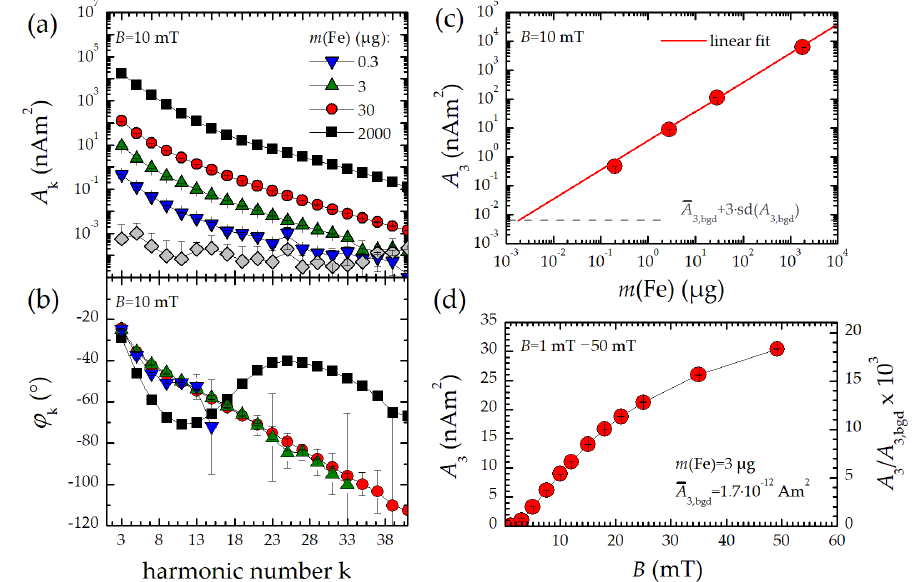
Figure 4. MPS signal of a serial dilution of FER: ( a ) MPS odd harmonic amplitudes; ( b ) odd harmonic phases; ( c ) concentration dependent 3rd harmonic amplitude A 3 (uncertainties below 1%); ( d ) excitation field amplitude dependent third harmonic amplitude A 3 of a m (Fe) = 3 µg FER sample (uncertainties below 1%). The right axis in the figure expresses the ratio between sample A 3 and background signal A 3,bgd of the measured third harmonic. Note, the connecting lines in ( a , b , d ) are a guide to the eye.